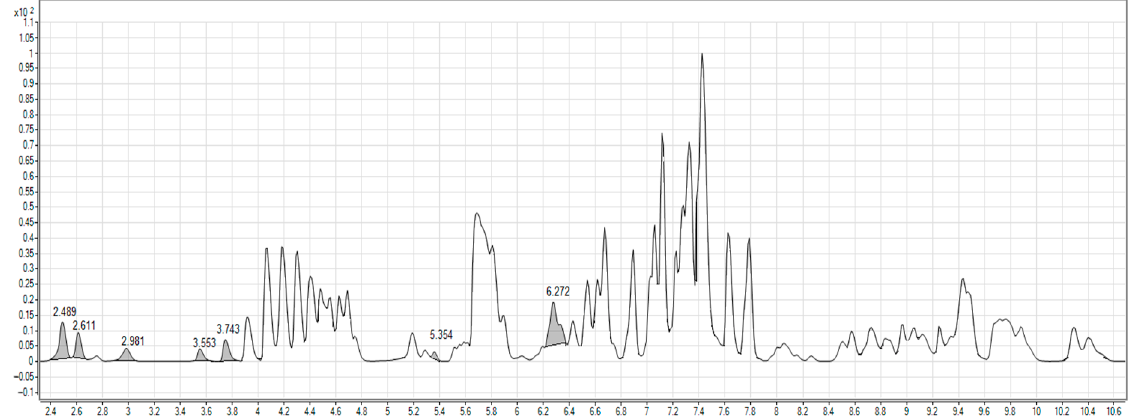
Figure 1. Representative TIC of diluted BRE; retention times were attributed by mass spectrometry analysis.